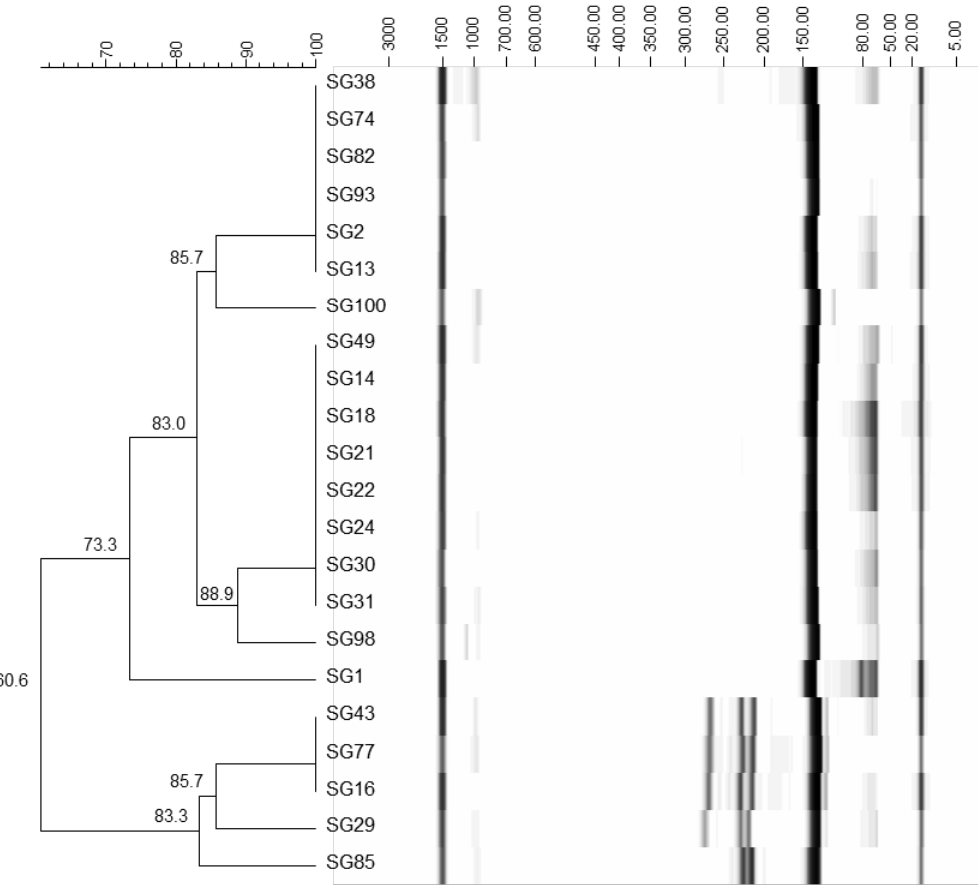
Figure 2. Phylogenetic tree (IGS2 314 region) of the 22 yeast strains detected in a sample of acidified wort from a plant run continuously for 20 years, and identified by sequencing (26S rDNA) as S. cerevisiae. Table 3. Results of the real-time PCR differentiation between top- (OG-COXII and SCTM) and bottom-